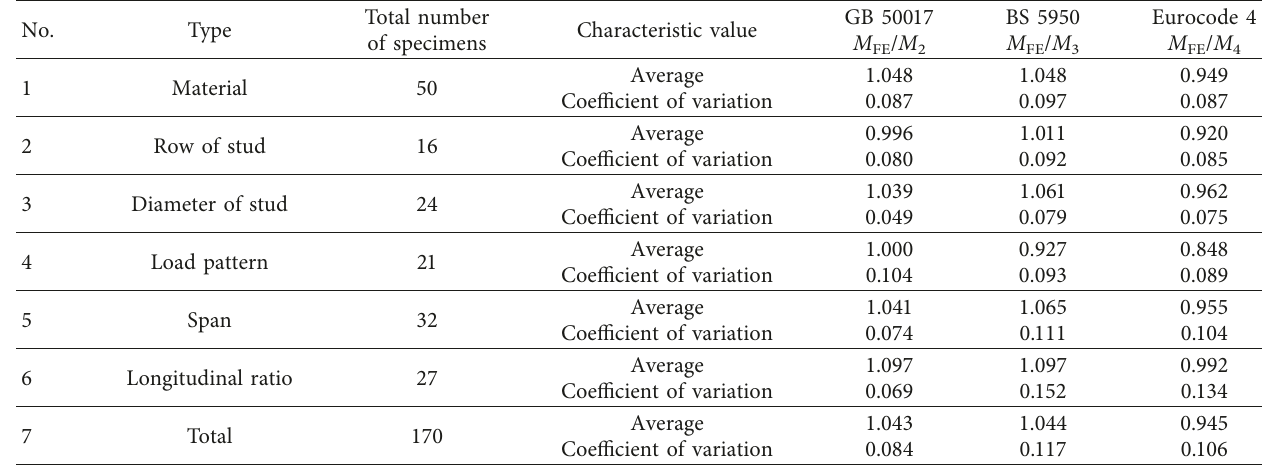
Table 5: Comparison between the results of the three standards and the FE